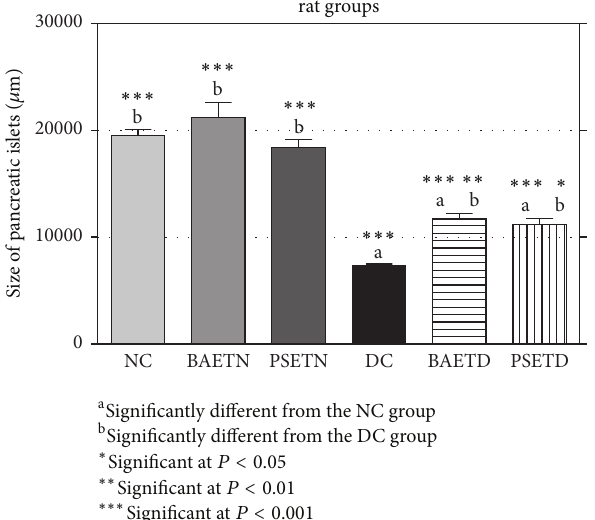
Figure 8: Administration of Balanites aegyptiaca fruits and Pet- roselinum sativum leaf aqueous extracts to the diabetic rats exhibited a significant increase in the mean size of the islets of Langerhans as compared with the DC